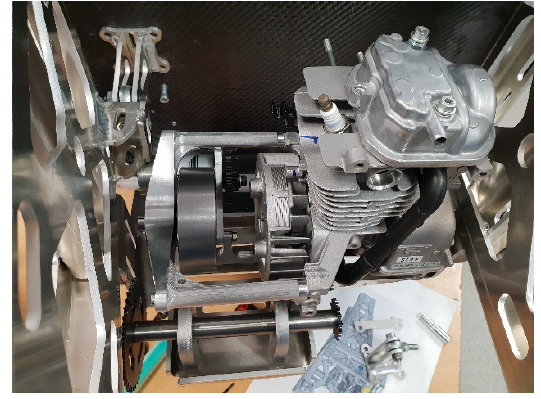
Figure 27. Mounted propulsion mechanism in the rear axle.